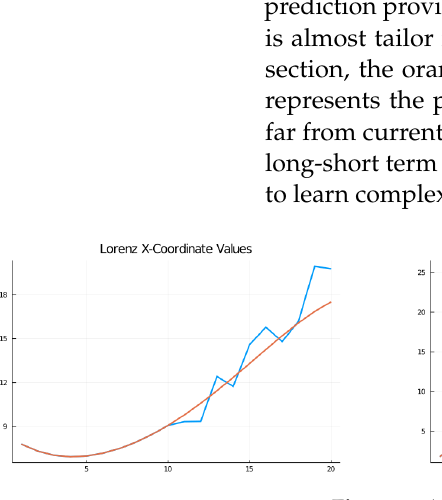
Figure 7. 10-step ahead predicted coordinate values.